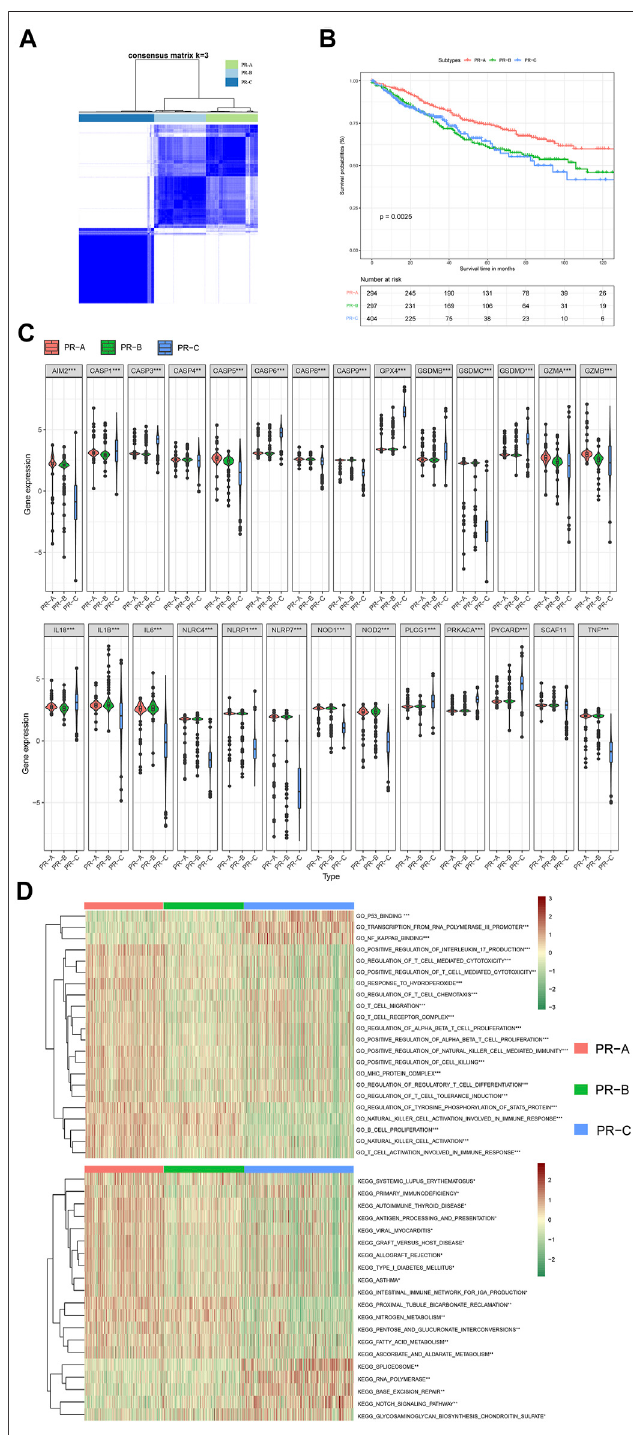
FIGURE 2 | Subgroups of colon cancer related by pyroptosis-related regulators. (A) The consensus score matrix of all colon cancer patients when k (cid:1) 3 in three cohorts based on the three eligible colon cancer (CC) cohorts of gene- expression data (GSE39582, GSE33113, and The Cancer Genome Atlas — Colon Adenocarcinoma (TCGA-COAD)). Two samples were more likely to be grouped into the same cluster when there was a higher consensus score